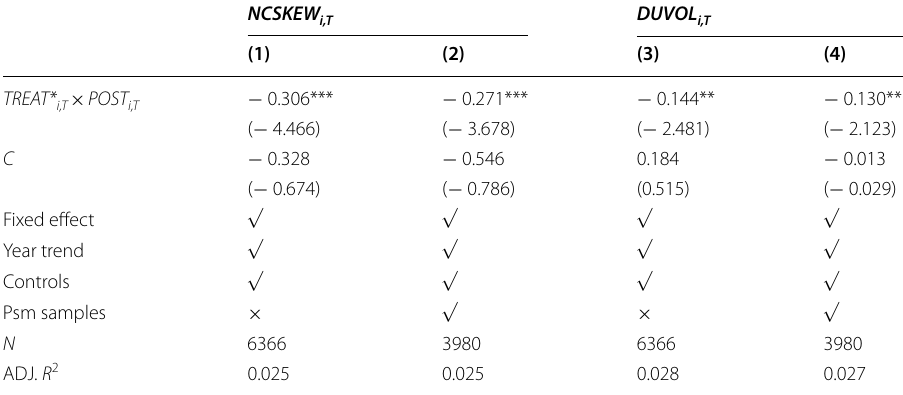
In this paper, ***, **, and * represent the significance levels of 1%, 5%, and 10%, respectively. The t-value is in